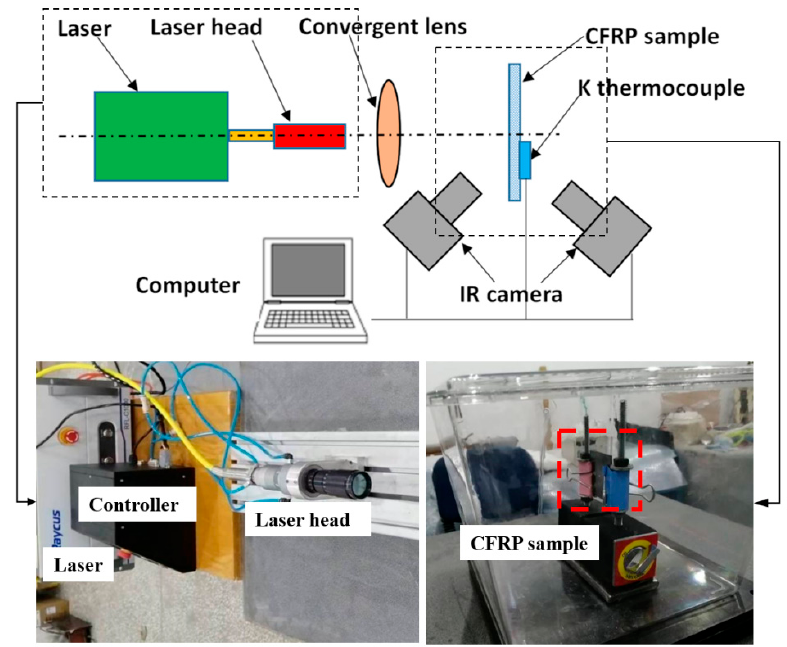
Figure 3. Schematic representation of the experimental setup applied for the investigation of laser irradiation.